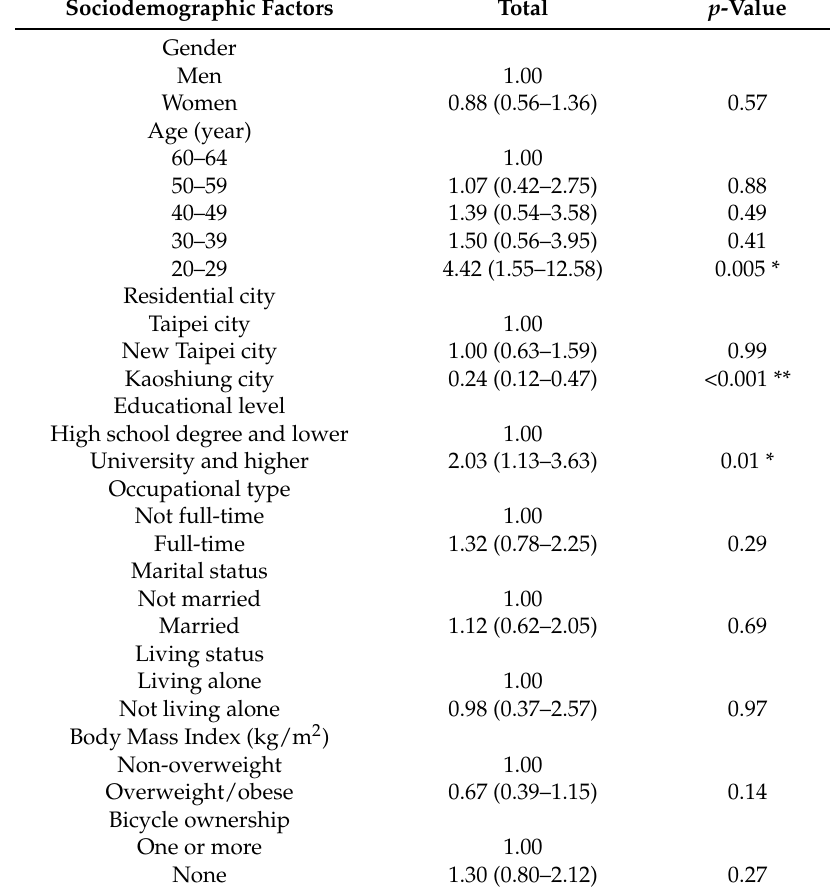
Table 2. Sociodemographic factors associated with public bicycle use among Taiwanese